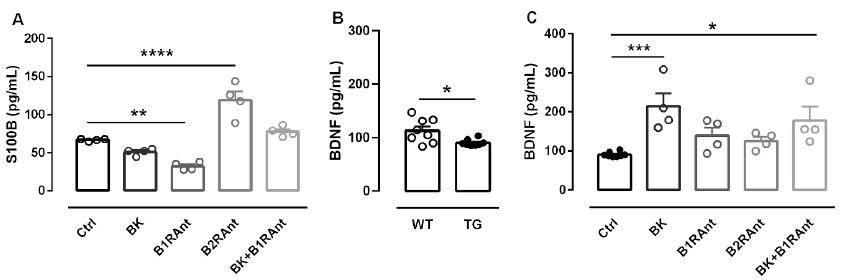
Figure 7. B2R is important in the process of neuronal protection provided by the KKS system. After 20 DIV of treatment with BK, B1RAnt, B2RAnt, or BK + B1RAnt, the culture medium was collected and the S100b and BDNF levels were analyzed by Elisa. ( A ) S100B concentration after treatments. ( B ) BDNF concentration in 12-month-old WT and TG animals. ( C ) BDNF levels in 12-month-old TG animals after treatments. Histograms and vertical bars show the mean ± SEM. NT—untreated slices; BK—bradykinin-treated slices; B1RAnt—slices treated with B1R antagonist [des-Arg10]-Hoe-140; B2RAnt—slices treated with B2R antagonist BDZ; BK + B1RAnt—slices treated with bradykinin and B1R antagonist [des-Arg10]-Hoe-140. * p < 0.05; ** p < 0.01; *** p < 0.001; **** p < 0.0001. ( A , C ) Data were analyzed with one-way ANOVA followed by Dunnett’s multiple comparison test. Data in B were analyzed with Student’s t -test. Biological samples of four animals were used for each